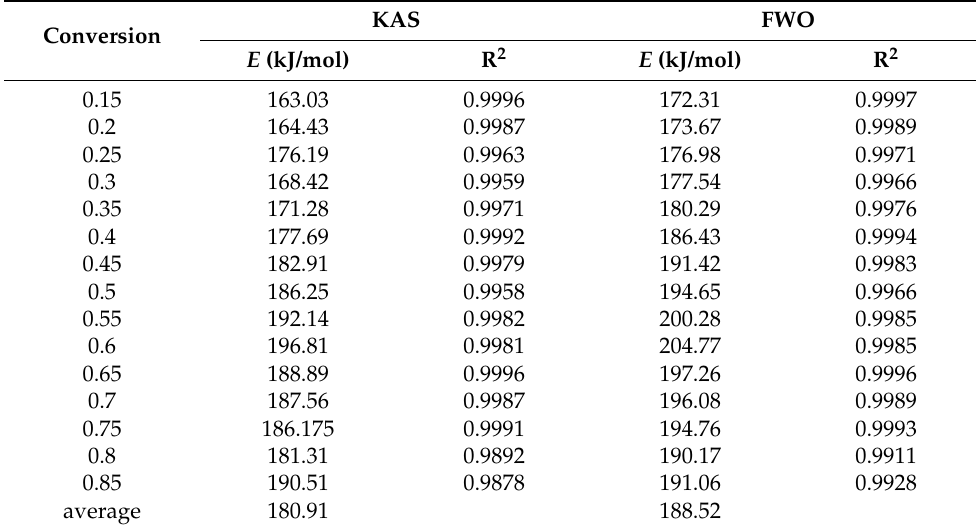
Table 2. Activation energy values at different conversion rates.